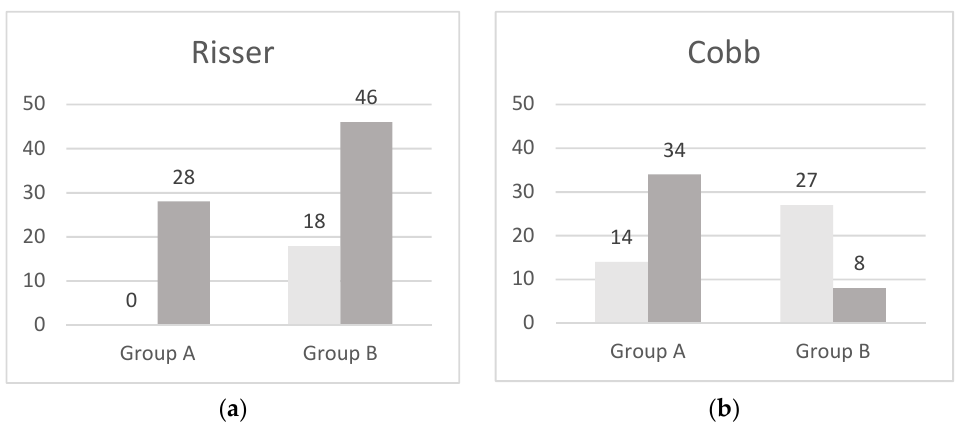
Figure 1. Histograms of the Risser value ( a ) and Cobb angle ( b ) in Group A (comparison before/after RPE, Risser p ≤ 0.007, Cobb p ≤ 0.005) and in Group B (comparison with RPE and after removal, Risser p ≤ 0.01, Cobb p ≤ 0.01).